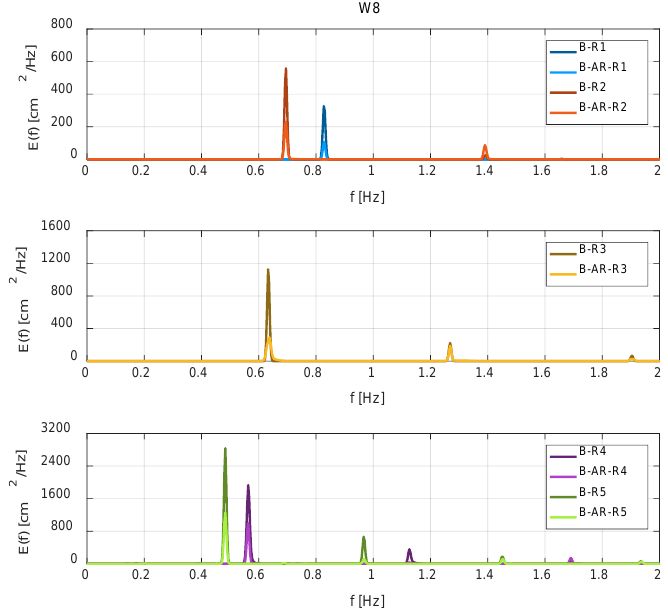
Figure 4. Spectral analysis at wave gauge of W8 (location shown in Figure 2) in regular wave tests.